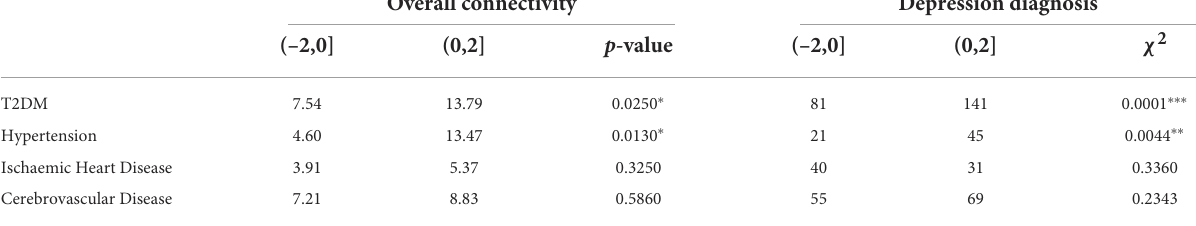
TABLE 3 Comparison between network connectivity for each